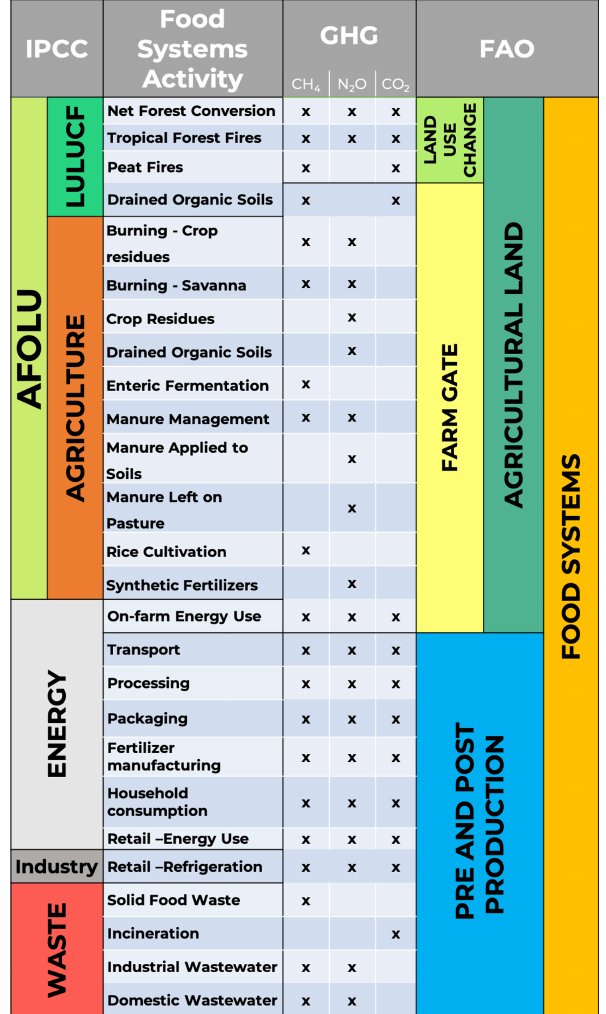
Figure 1. Mapping of emissions across agri-food systems. Left: IPCC sectors and processes used in national GHG emissions inven- tories. Right: food and agriculture sectors and categories aligned to FAO’s